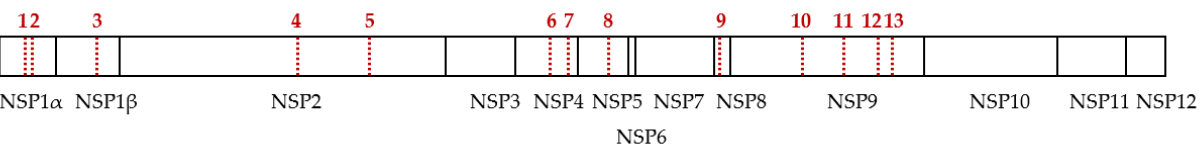
Figure 3. Position of identified MHC-I-bound peptides (dashed red lines) from infected PAMs within the PRRSV ORF1 polyprotein. Numbers above the red dashed lines correspond with Table 2. NSP, non-structural protein.